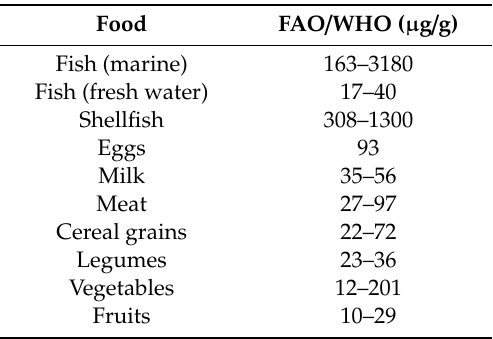
Table 2. Iodine content in foods by FAO / WHO